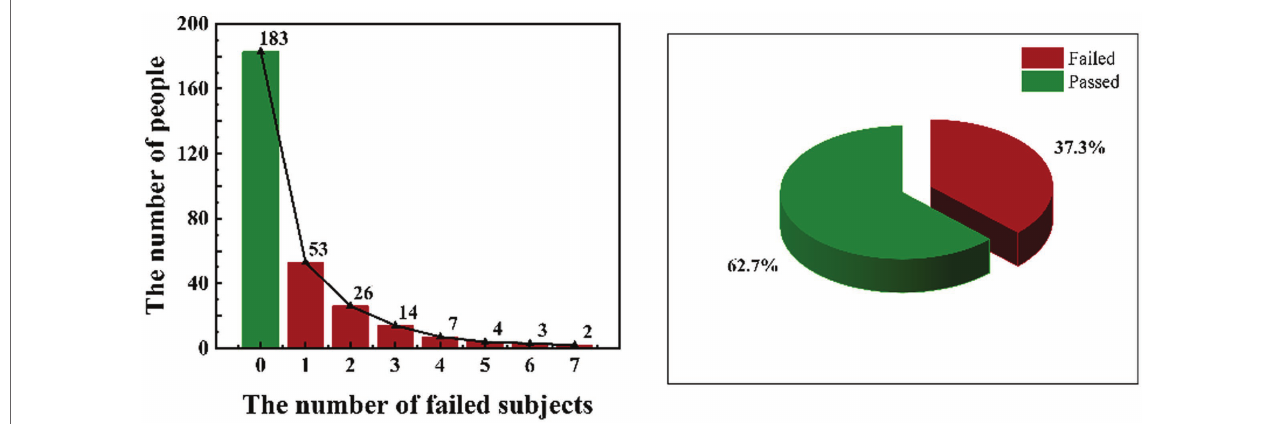
FIGURE 1 | An overall academic performance.